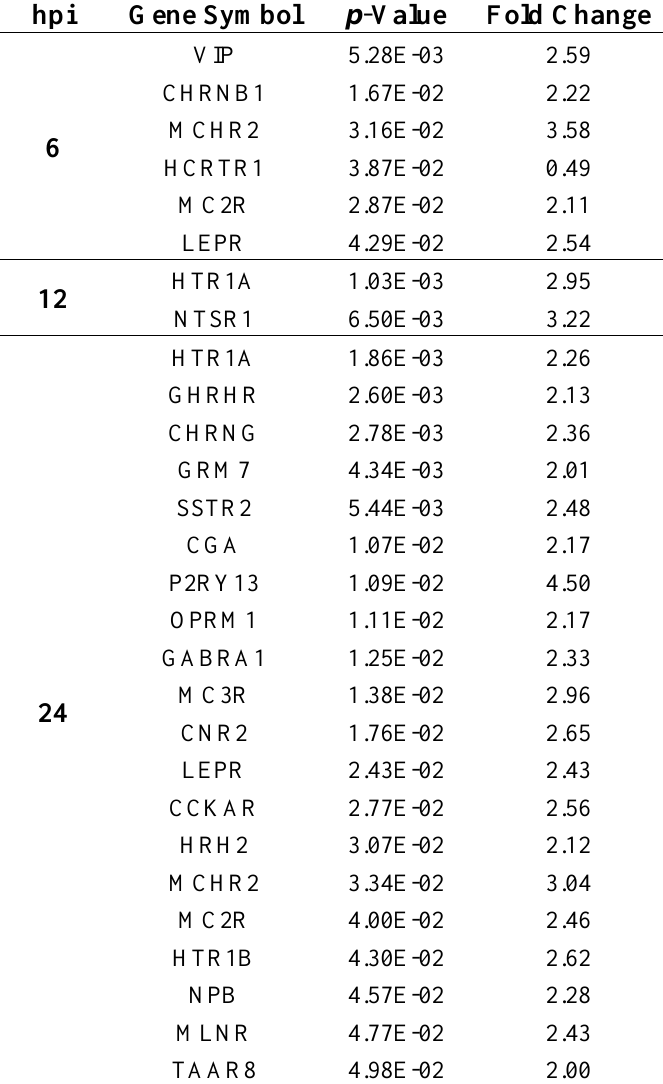
Table 3. Differentially expressed genes in neuroactive ligand-receptor interaction pathway in response to HM/06